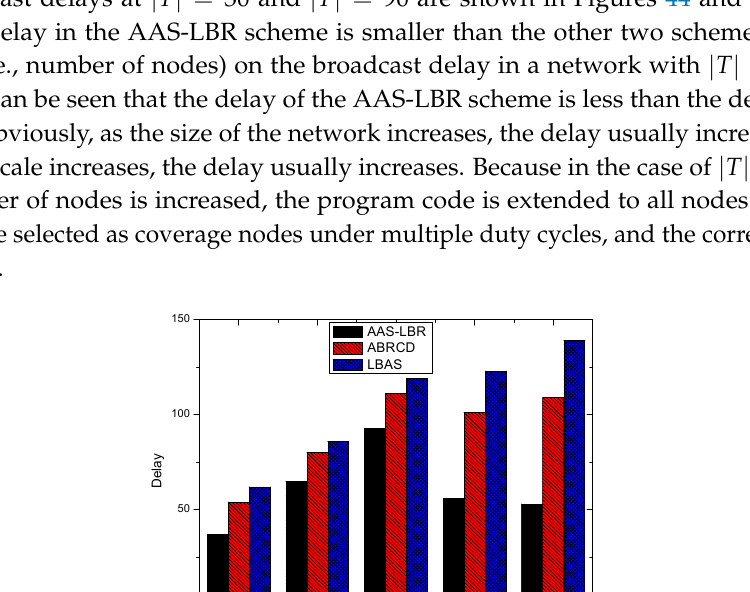
Figure 43. The impact of |𝑇| with fixed network nodes = 600 with fixed on the total number of broadcast.